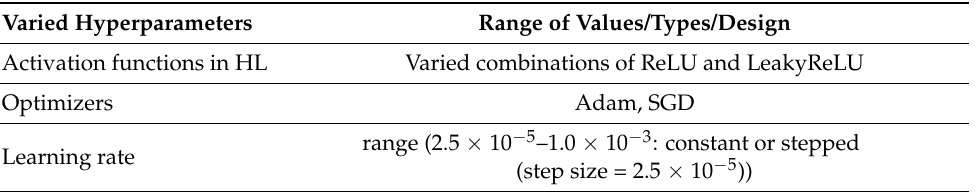
Table 2. Design variation in the three hyperparameters for sorting out the best performing model. Here, ReLU stands for rectified linear unit, LEAKY-ReLU is a modified rectified linear unit, Adam name is derived from adaptive moment estimation, and SGD stands for stochastic gradient